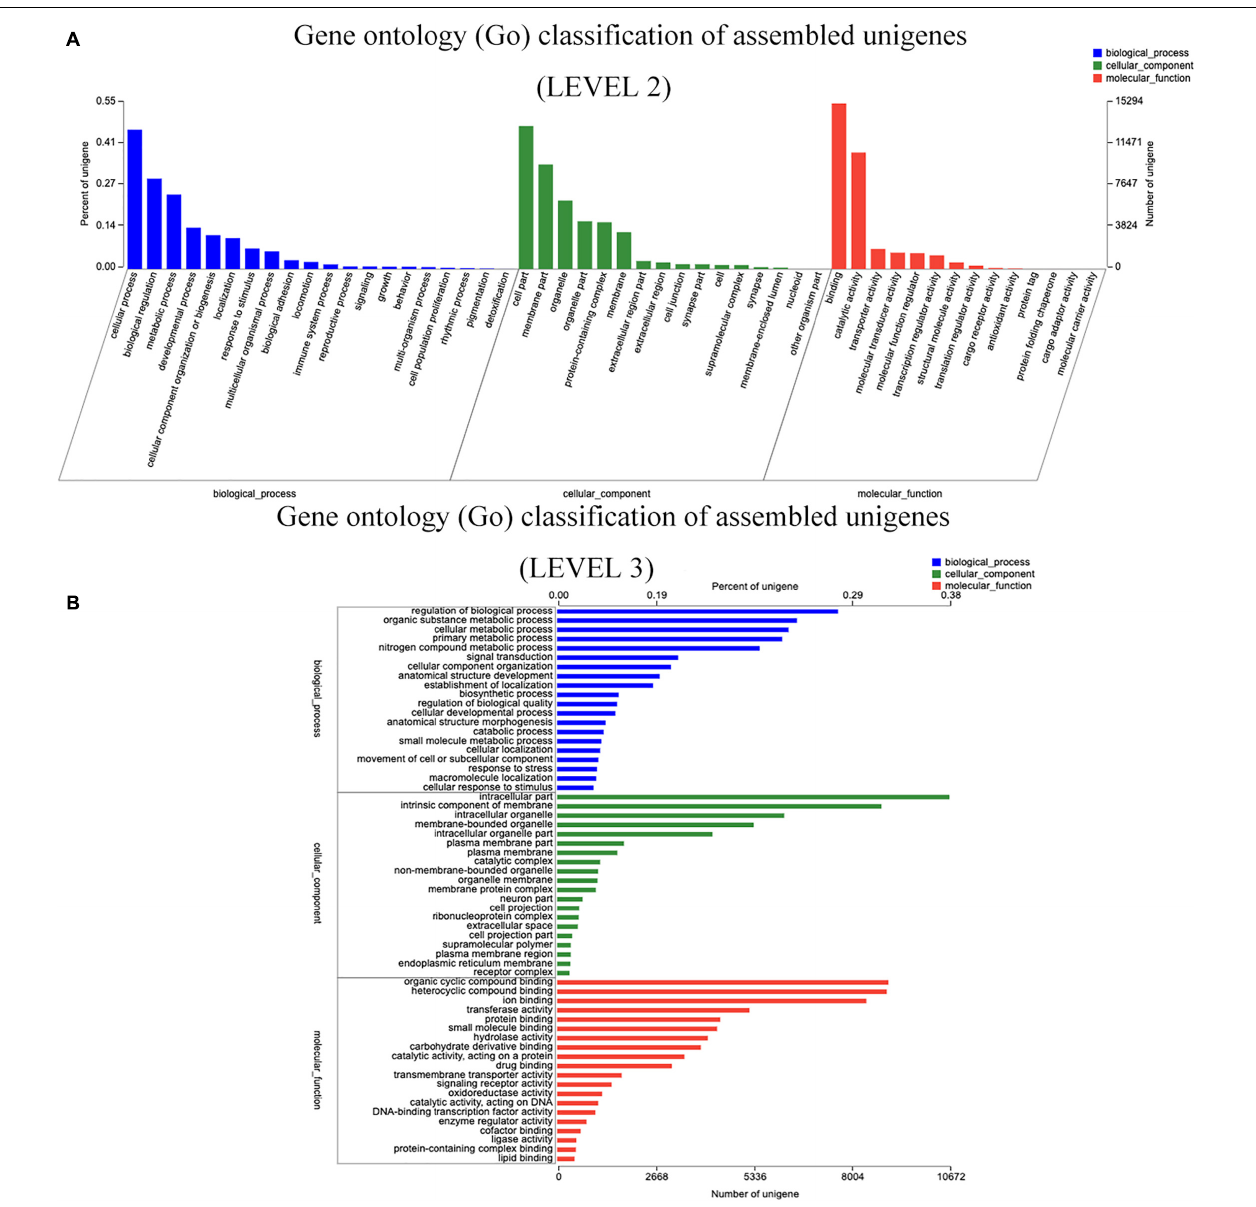
FIGURE 2 | Gene ontology (GO) classification of assembled Unigenes. (A) The database annotation of GO at level 2 classification of Unigenes. (B) The database annotation of GO at level 3 classification of Unigenes.